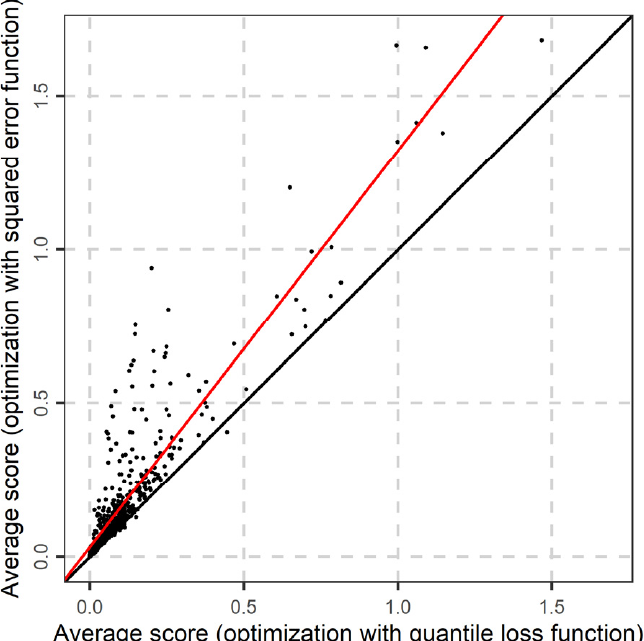
Figure 4. Scatterplot of the mean quantile scores at the level a = 0.500, as computed for the testing periods and separately for each of the 511 river basins, in the case that the quantile loss function at the level a = 0.500 is minimised ( x -axis), and in the case that the squared error function is minimised ( y -axis) for the calibration of the GR4J model.